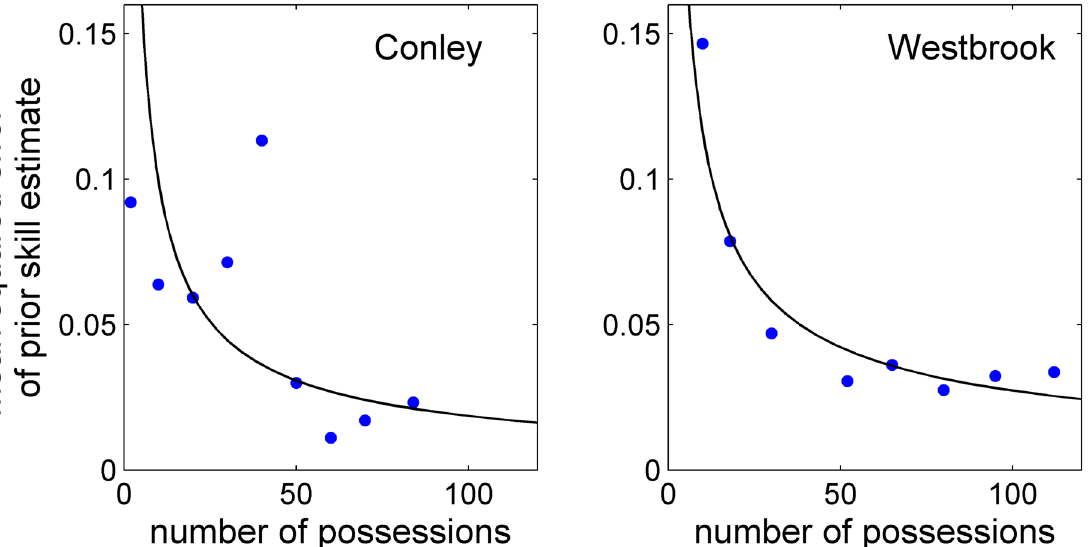
Fig 3. The mean squared difference between the skills inferred from lineup 1 and the skills inferred from lineup 2 as a function of the number of possessions analyzed from lineup 1. As more data is analyzed, the inferred skills for both Conley and Westbrook converge toward the prior estimate based on their performance in lineup